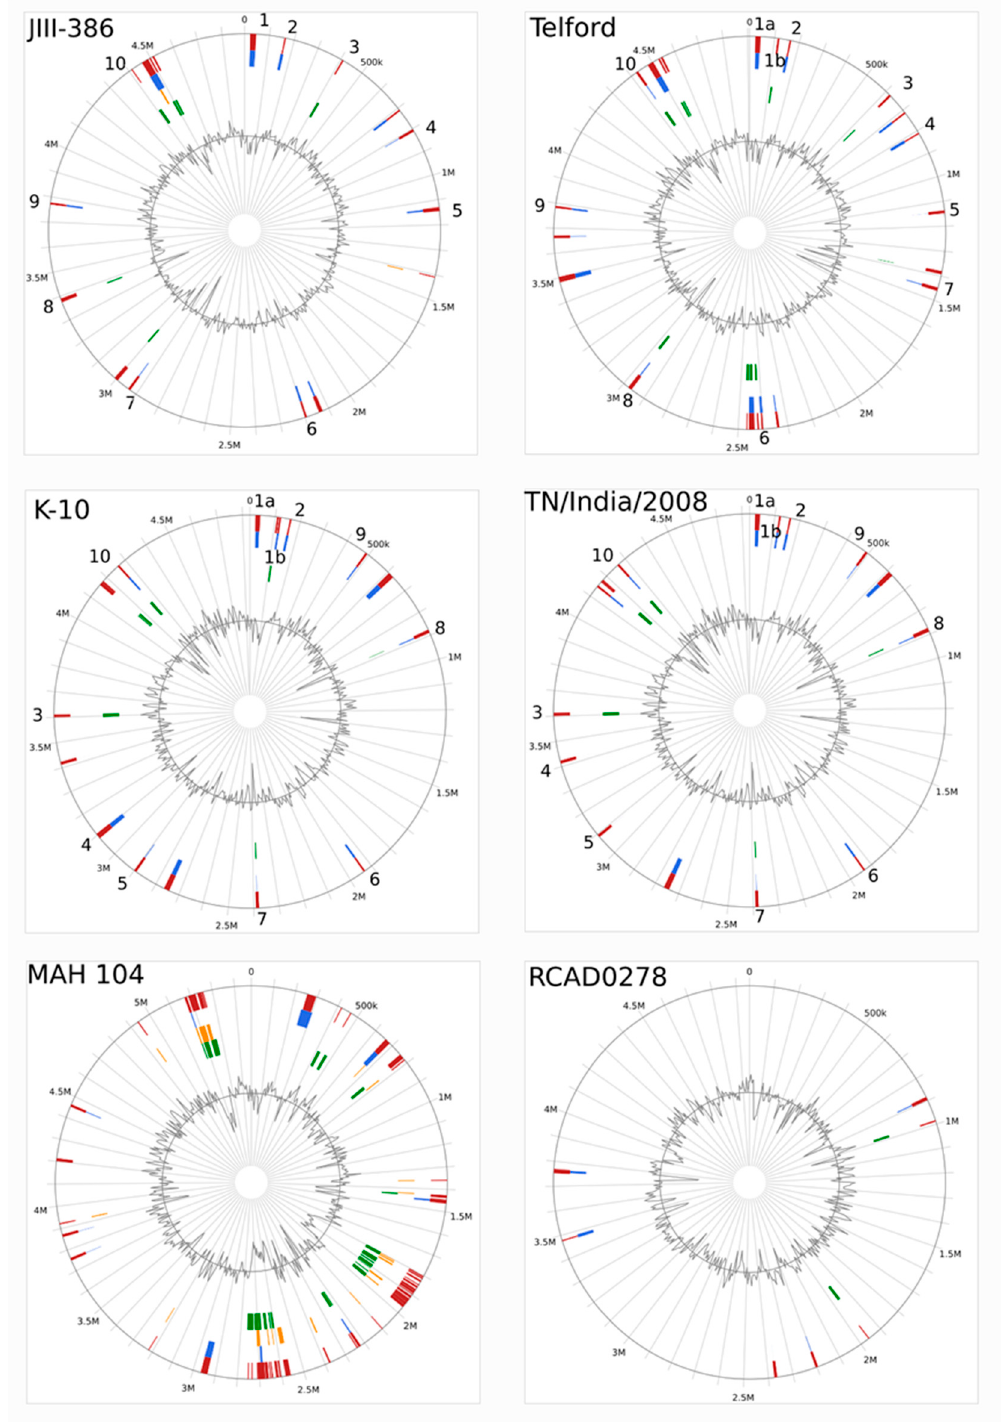
Figure 6. Plot of genomic islands in circular maps of 6 Mycobacterium avium strains using Island Viewer 4. This method uses both Island Pick (green bares), Island Path DIMOB (blue bares), an integrative approach (red bares), as well as manual inspection to identify differences in external annotation. The inner most circle in the figure represents the GC content, with values below the average on the inside and values above the average on the outside of the circle. Genomic positions are represented in bp. Represented strains are: JIII-386 (MAP-S/type III), Telford (MAP-S/type I), K-10 and TN/India 2008 (MAP-C), MAH 104 ( M. avium subsp. hominissuis ), and RCAD0278 ( M. avium subsp. avium ). Labels numbered 1 to 10 correspond to genomic islands detected in MAP-S and MAP-C strains (see Tables S8 and S9) and are based on GIs in JIII-386: 1 = J1a, 2 = J2, 3 = J3, 4 = J5, 5 = J6, 6 = J8, 7 = J9, 8 = J11, 9 = J12, 10 = J13).